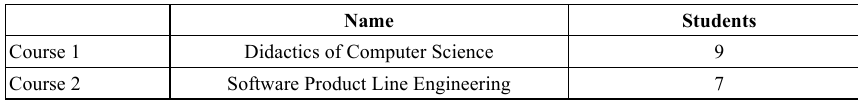
Table 2. Overview courses